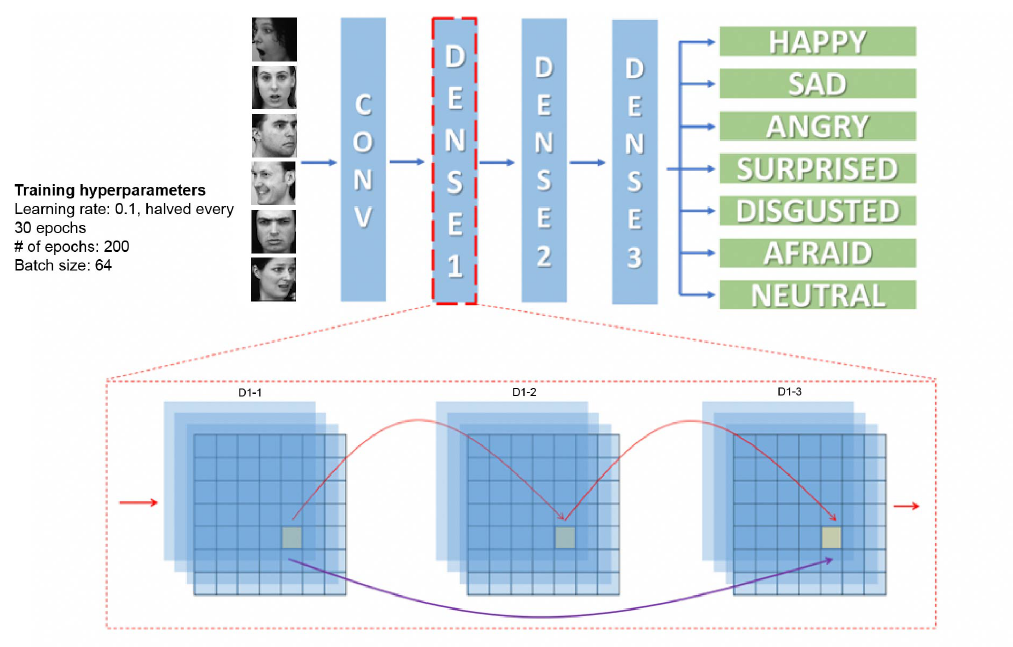
Figure 2. Neural network architecture. Top: Each network consists of a convolutional layer, three dense layers, and a linear classifier. Expression classification is used as an example here. Bottom: Single dense block; red arrows represent connections that would exist in a typical convolutional neural network, the purple arrow represents connections that are unique to the densely-connected network. Selected images from KDEF dataset: AF01AFHR, AF02SUHL, AF05AFS, AM01ANS, AM10HAHL,